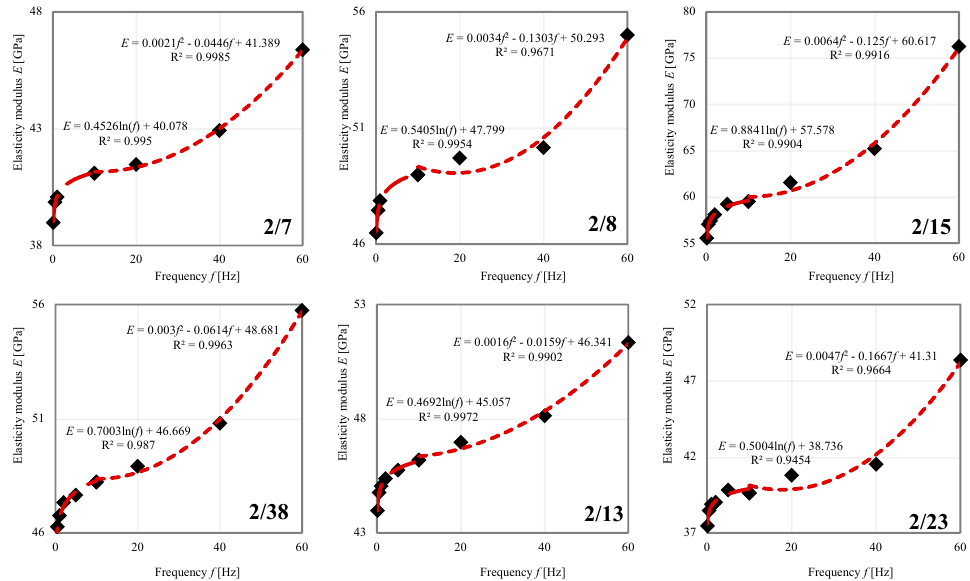
Figure 16. Dynamic modulus of elasticity of limestone samples saturated with distilled water.